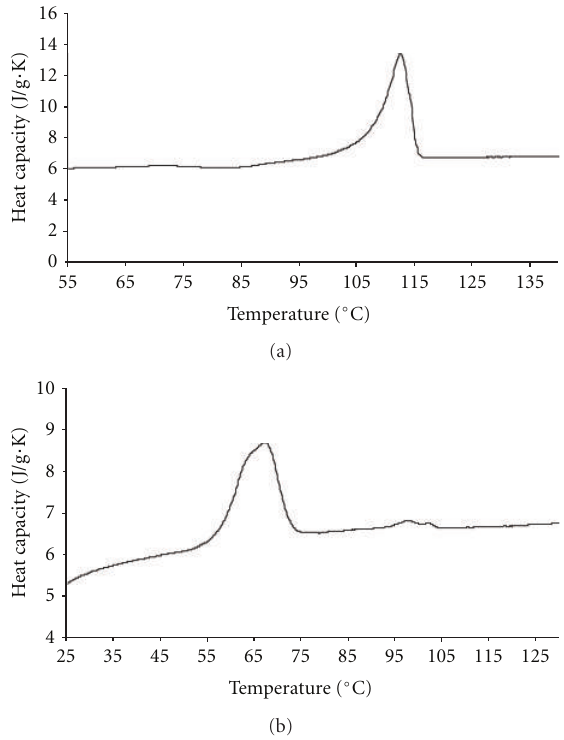
Figure 9: DSC thermograms of cholesteryl benzoate at a rate of 10K · min − 1 , (a) heating, (b) cooling.